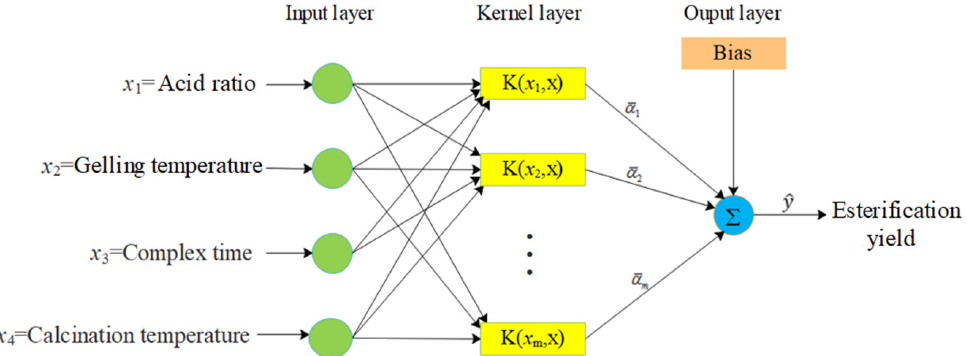
Figure 11. Neural network of SVM for estimation of